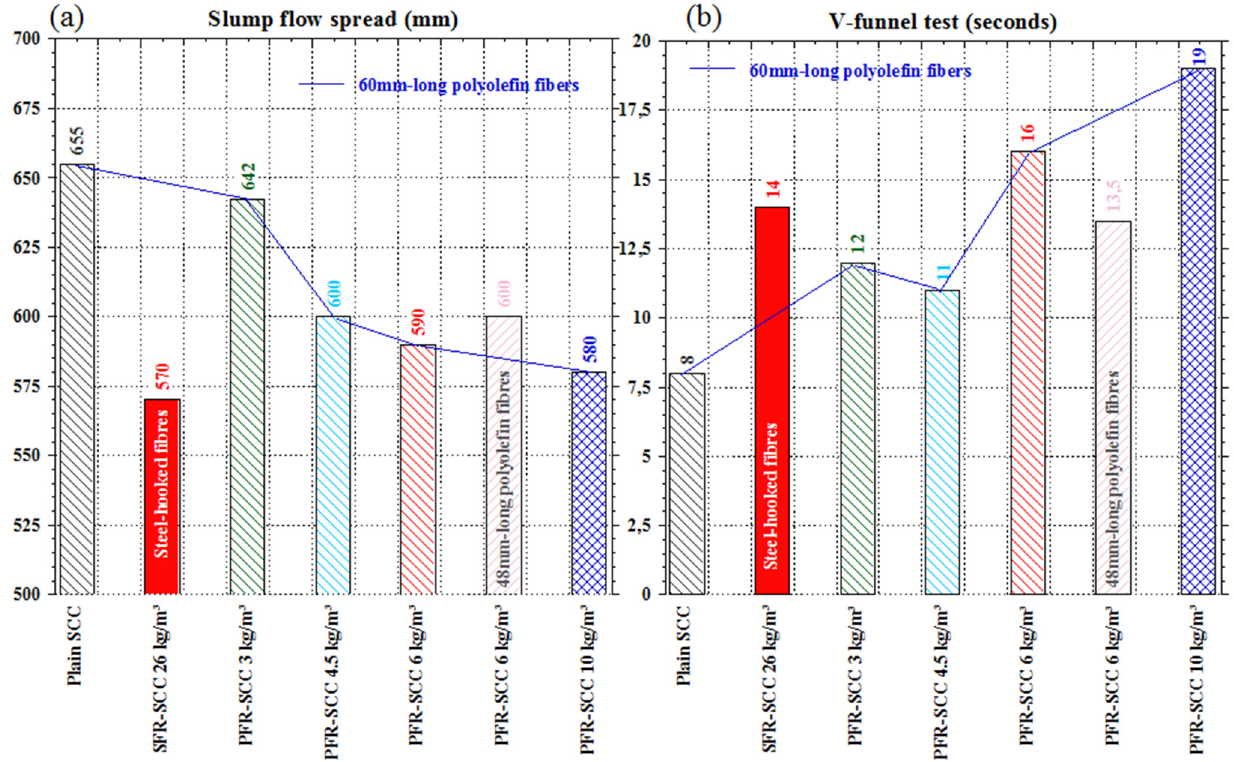
Figure 4. Fresh-state results with several fiber dosages: ( a ) Slump flow spread diameter; ( b ) V-funnel emptying